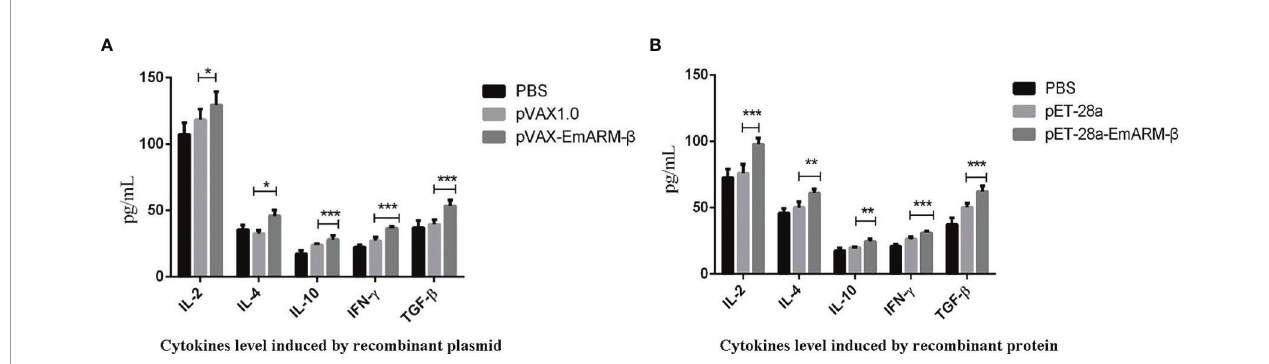
FIGURE 5 | Concentration measurement of serum cytokines induced by EmARM- b . Serum cytokines concentration induced by EmARM- b was measured by ELISA assay. (A) Cytokines level induced by recombinant plasmid pVAX1-EmARM- b . (B) Cytokines level induced by recombinant protein pET-28a-EmARM- b . *p < 0.05; **p < 0.01; ***p